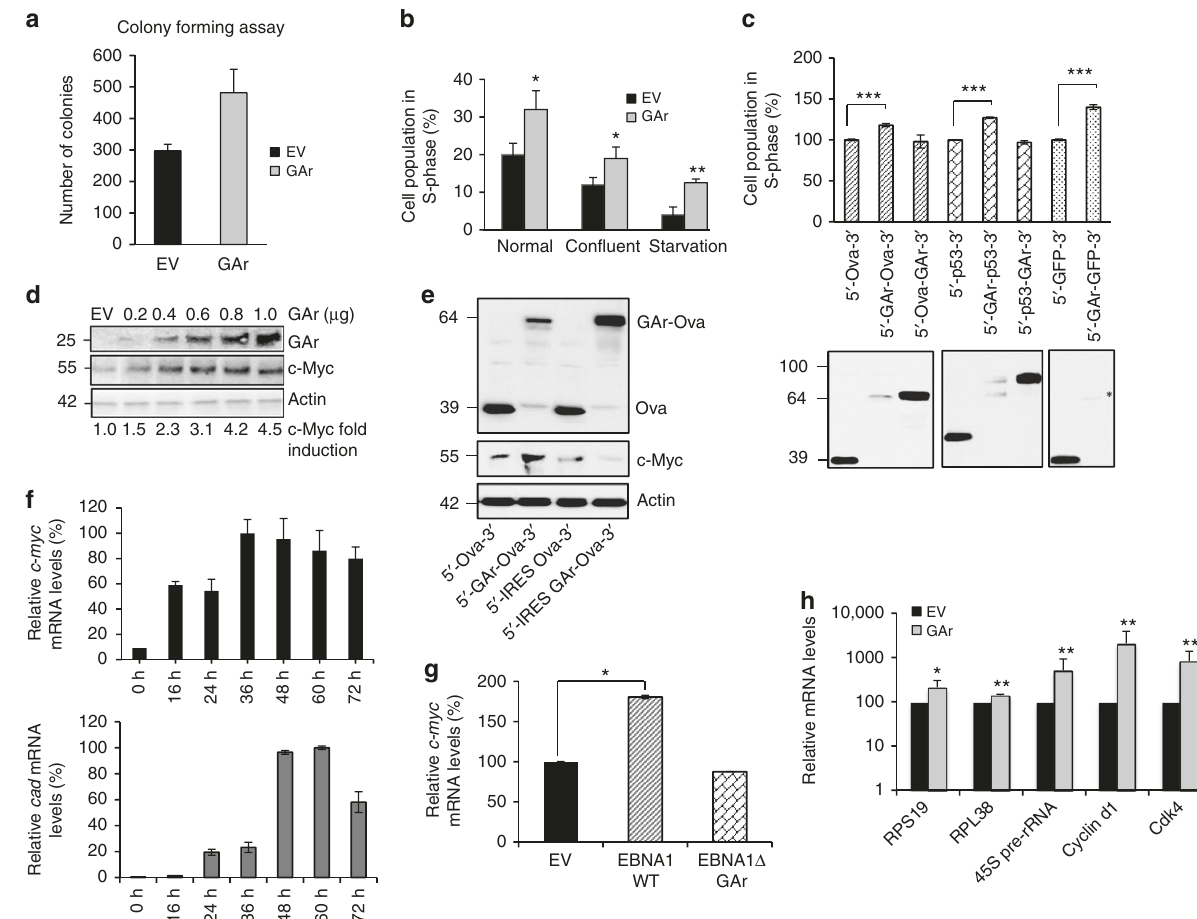
Fig. 1 GAr-induced mRNA translation stress stimulates cell proliferation via c-Myc. a Colony forming assay. The number of colonies of H1299 cells expressing the gly-ala repeat (GAr) of the EBV-encoded EBNA1, or plasmid control (EV), were counted after 15 days in selection medium and plotted. b The graph shows the percentage of proliferating cells (S-phase) expressing the GAr or EV under indicated growth conditions as determined by FACS analysis. c Western blots (lower panel) show that fusing the GAr to the N terminus of the open reading frames of chicken ovalbumin (Ova), (GAr-Ova), p53 (GAr-p53) or GFP (GAr-GFP) suppresses mRNA translation, in contrast to when inserted at the C-terminal end (Ova-GAr or p53-GAr). The graph (upper panel) shows the relative number of cells in S-phase expressing the indicated constructs. d Western blots show the expression of c-Myc following expression of the indicated quantities of GAr cDNA in H1299 cells. The numbers below the blots indicate c-Myc levels normalised to actin. e Fusing the 5 ′ UTR of c-myc that contains IRES to the 5 ′ of GAr-Ova (IRES GAr-Ova) abrogates translation suppression and averts c-Myc induction. f The upper graph shows RT-qPCR of c-myc mRNA levels at indicated time points following expression of the GAr. The data show the relative c-myc/GAPDH mRNAs ratio and the highest value at 36 h is set to 100%. The lower graph shows the relative values of c-Myc-induced CAD mRNA levels relative to GAPDH . The highest value is set to 100%. g RT-qPCR analysis show the relative c-myc mRNA levels normalised to GAPDH in H1299 cells expressing EV, EBNA1 WT or EBNA1 Δ GAr. h RT-qPCR analysis of c-myc target genes (Cdk4, cyclin d1, 45S pre-rRNA, Rps19 and Rpl38) in cells expressing EV or GAr. Note the logarithmic scale. FACS analyses show mean values with s.d. from at least three independent experiments. Actin was used as a loading control. For western blots, RT-qPCR and colony formation assays representative of three independent experiments were shown with s.d. Statistical signi fi cance was calculated using t tests (*** p < 0.001, ** p < 0.05 and * p < 0.1) 48 h (Fig. 1f, upper and lower graphs). Similarly, when we (Supplementary Fig. 3b). This discrepancy between preventing expressed EBNA1 WT in H1299 cells, there was a signi fi cant cell proliferation and c-Myc target genes indicates that other induction of c-Myc, whereas an EBNA1 construct lacking the GAr-induced factors are promoting cell proliferation. The GAr sequence (EBNA1 Δ GAr) had no effect, con fi rming the treatment with F4-10058 did not prevent the GAr from inducing importance of the GAr in c-Myc induction (Fig. 1g). We also c-Myc expression (Supplementary Fig. 3c). observed a signi fi cant increase in mRNA levels of c-Myc Pol II ( Cdk4, Cyclin D1, Rps19 and Rpl38 ) and Pol I ( 45S pre-rRNA ) Induction of c-myc mRNA levels by GAr is mediated by E2F1 . target genes following GAr expression (Fig. 1h). When the c-Myc inhibitor F4-10058 was added, we observed an ~80% suppression of cells in S-phase at 16 µ M in control cells, whereas the corresponding suppression in GAr-expressing cells at the same